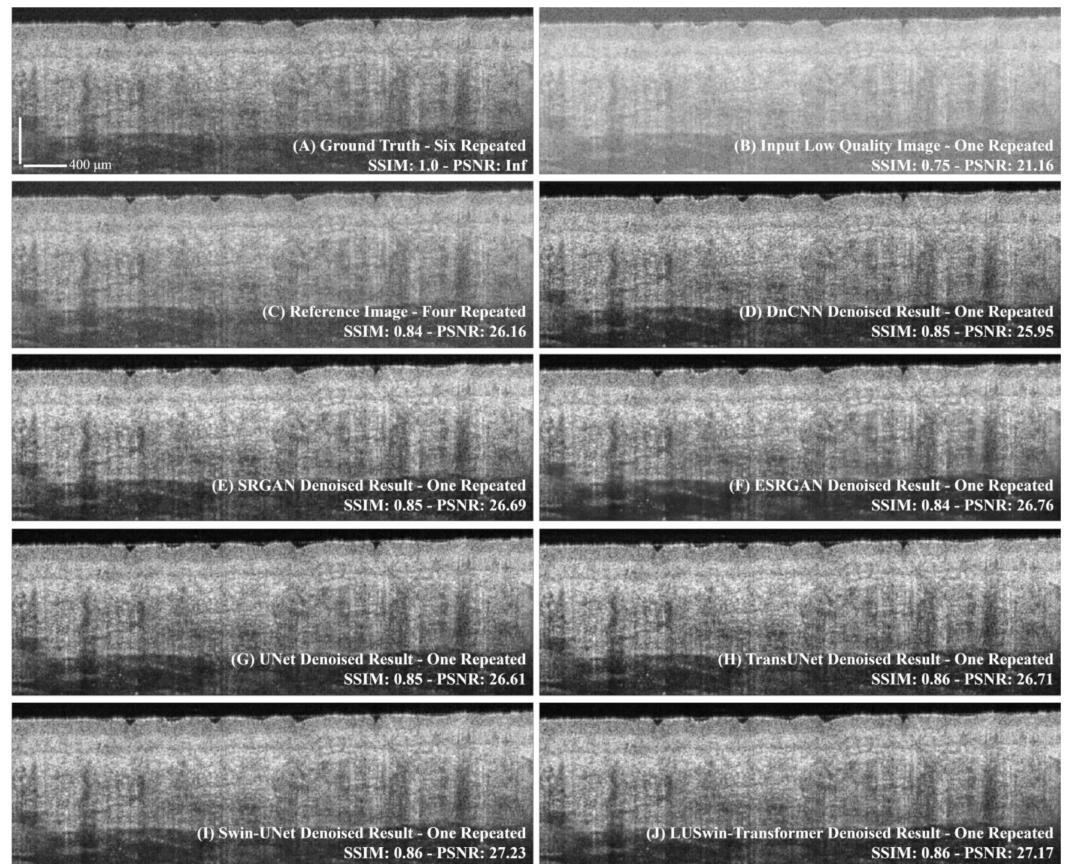
Figure 4. The visual comparison between the different methods. The image is selected from par- ticipant #004, representing the neural network performance on the palm thenar. ( A ) High-quality ground-truth image with six-repeated scans. ( B ) Low-quality input image with one-repeated scan. ( C ) High-quality reference image with four-repeated scans. ( D – J ) are the neural networks’ denoised results from ( D ) DnCNN, ( E ) SRGAN, ( F ) ESRGAN, ( G ) UNet, ( H ) TransUNet, ( I ) Swin-UNet, and ( J ) LUSwin transformer. The white label is a scale bar with 400 µ m.